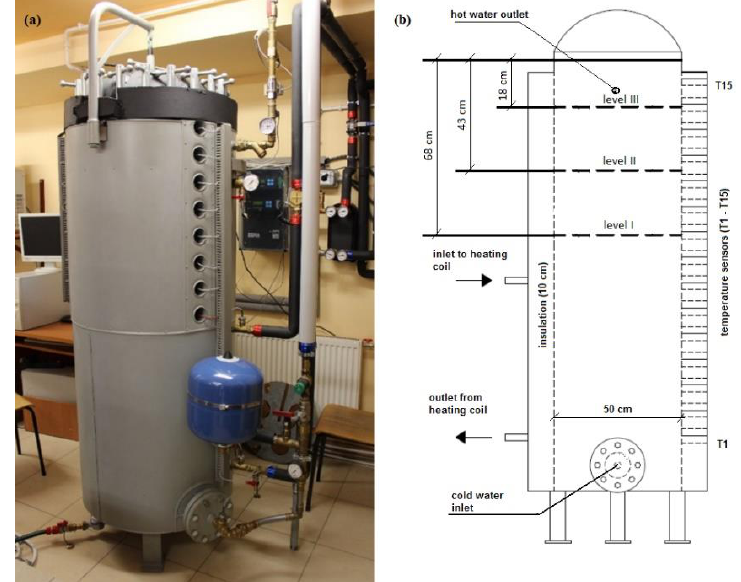
Figure 3. Hot water storage tank: ( a ) test setup; ( b ) schema.